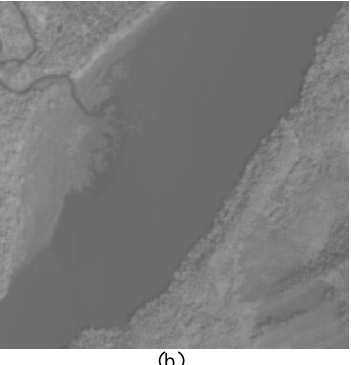
Figure 8 (a)local detail before correction(b) local detail after